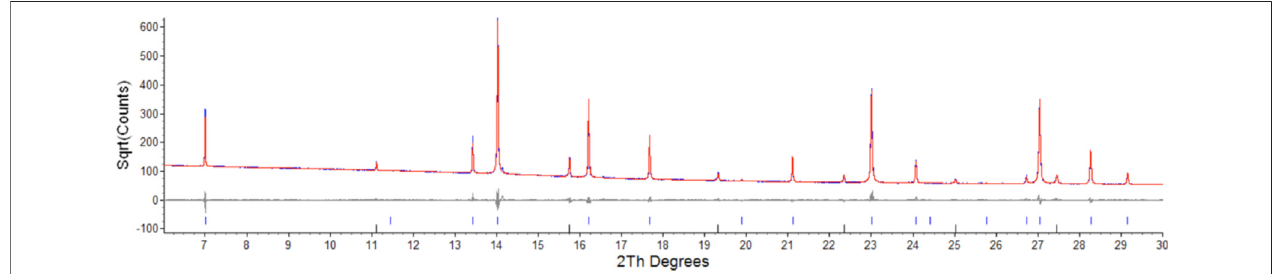
FIGURE1| Low angle section ofrietveld plotforthe (ErNd) 2 (TiZr) 2 O 7 sample,the red lineisdata,blue iscalculated, grey isthedifference plot, blue markersare the main phase and black markers are the unknown phase. Y axis is square root of counts to highlight the second phase, barely visible in a plot of counts vs. angle.